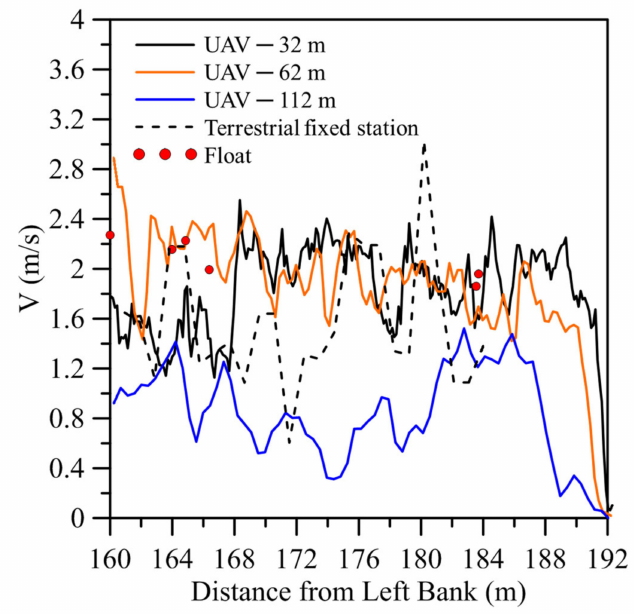
Figure 10. Comparison of measured surface velocities using LSPIV from UAV flight heights of 32 m, 62 m, and 112 m, LSPIV from terrestrial fixed stations, and the float method. Table 4. The statistical error and the measured surface velocity obtained using LSPIV derived from a UAV positioned at different flight heights and a terrestrial fixed station compared to that obtained using the float method.